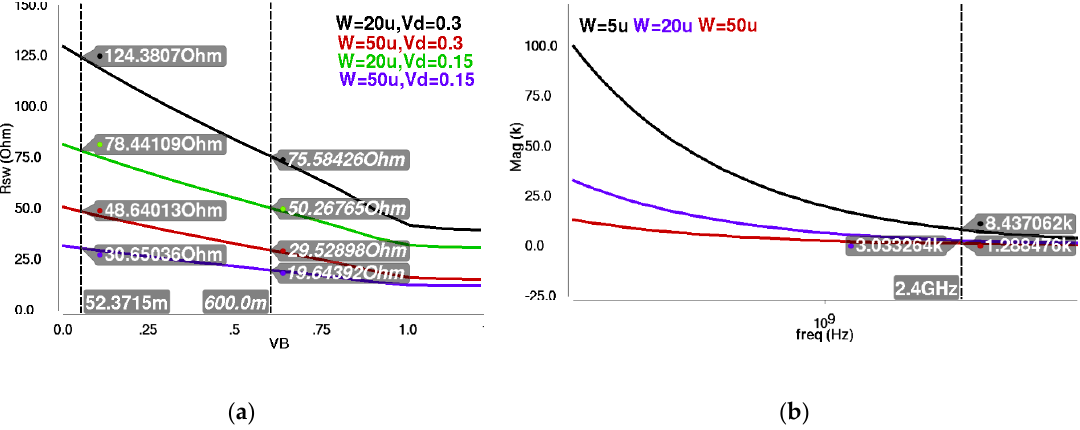
Figure 8. ( a ) The on-resistance of MOS; and ( b ) the output impedance of the subharmonic mixer (SHM) core.